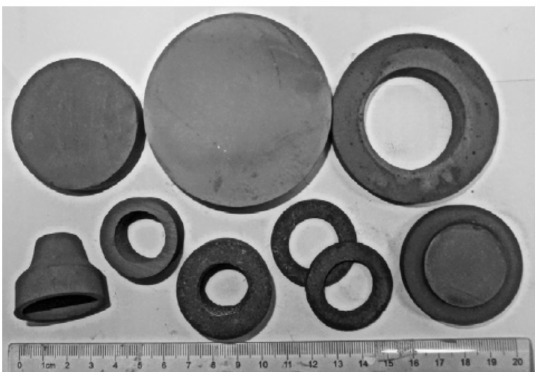
Figure 7. ZrB 2 -SiC ultra-high-temperature ceramic components. Reproduced with permission from